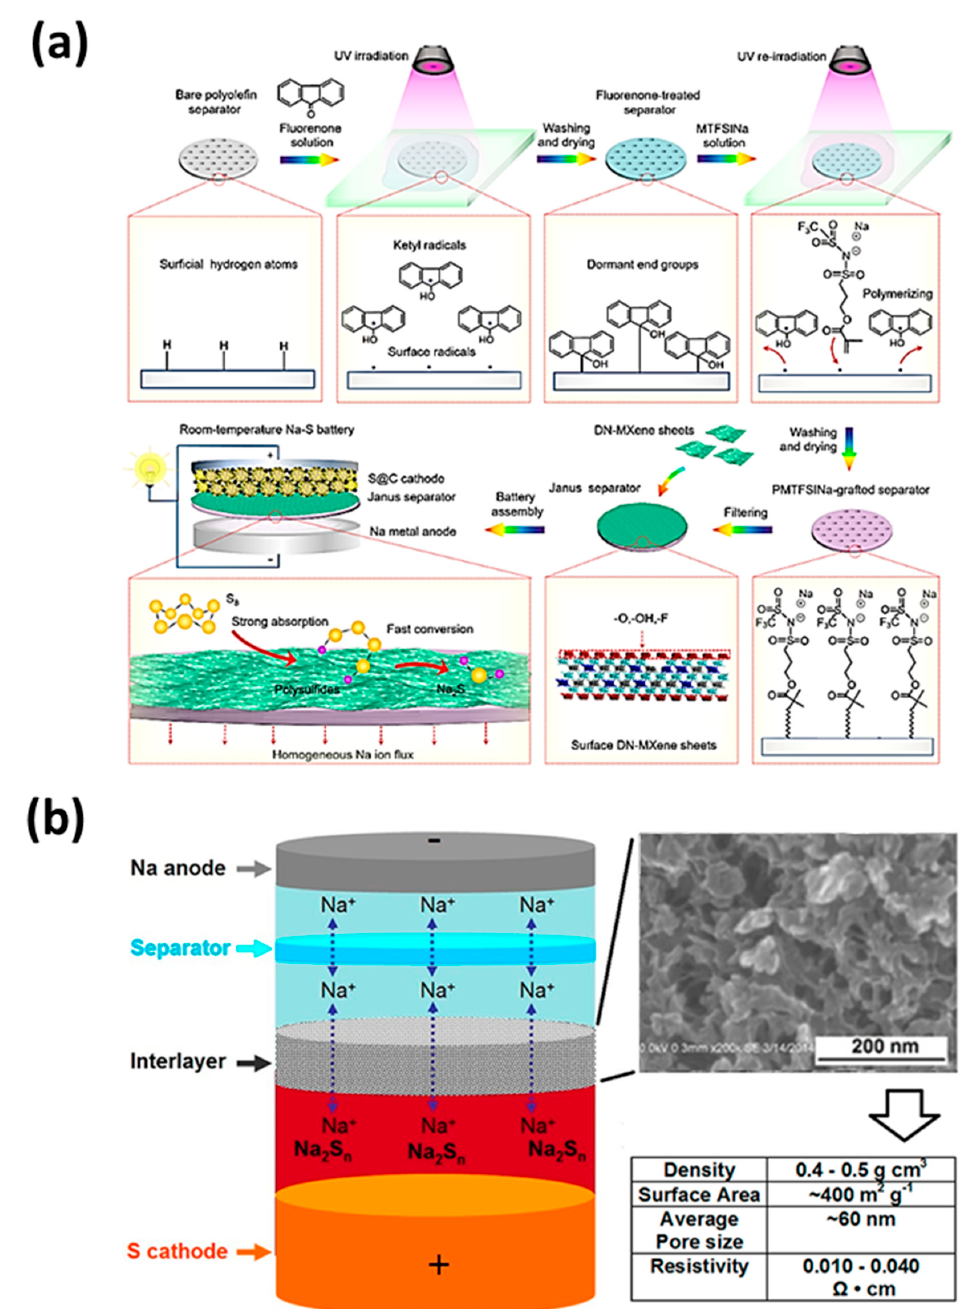
Figure 6. ( a ) Schematic illustration of the preparation of PMTFSINa-grafted side|DN-MXene coated side Janus separators for room temperature Na-S batteries. For the ball-and-stick model of DN-MXene, light cyan, gray, white, red and blue balls represent Ti, C, H, O and N atoms, respectively. ( b ) Schematic representation of the room-temperature sodium-sulfur battery with an interlayer, SEM image showing the structure of the carbon nanofoam and properties of the carbon nanofoam.